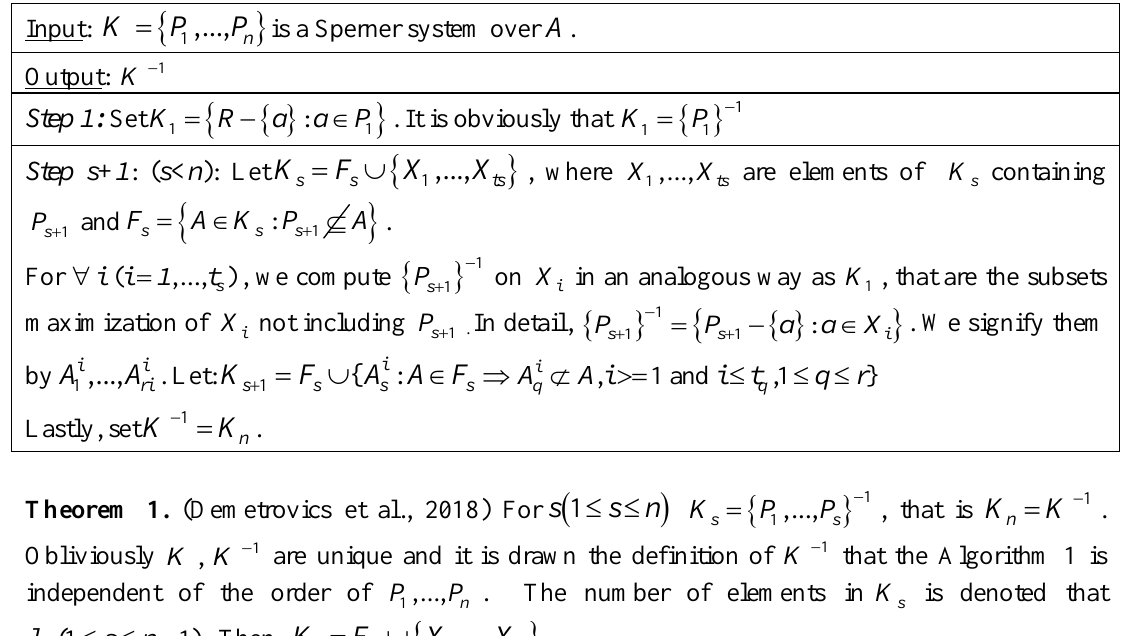
Algorithm 1. (Demetrovics et al., 2018) Find 1 − K in Sperner-system K